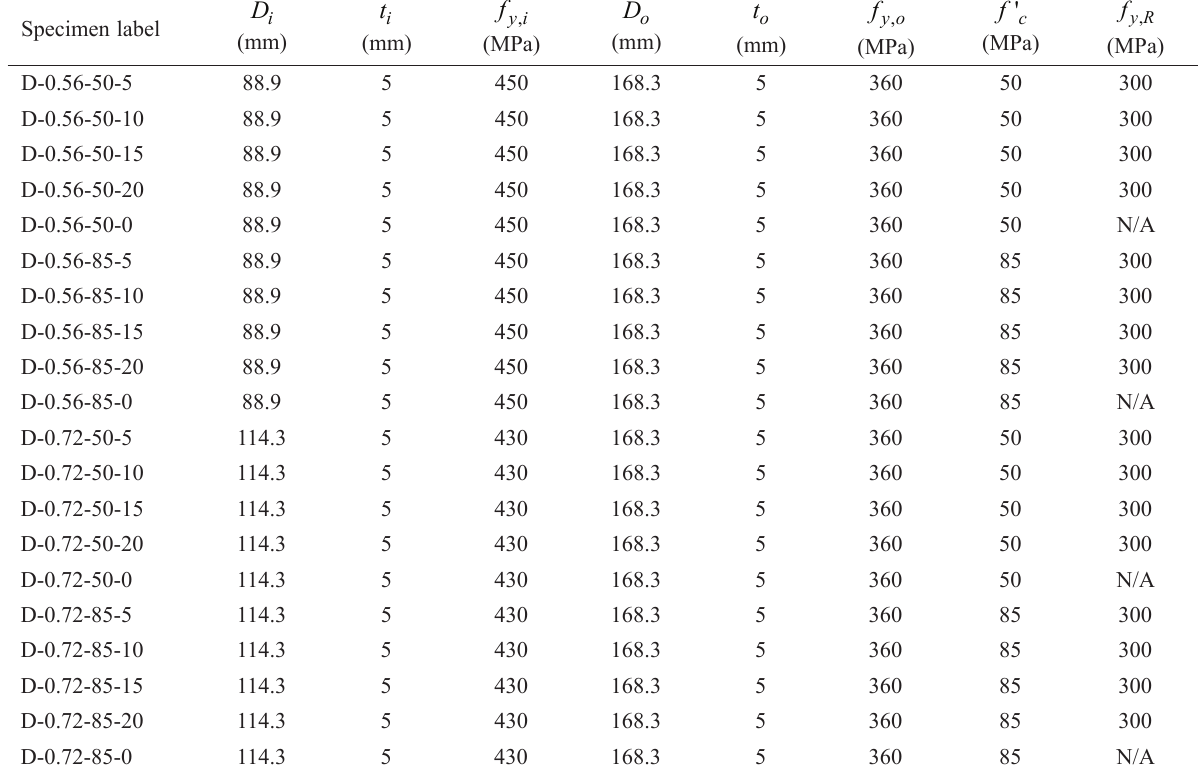
Table 1. Details of specimens and materials’ properties Specimen label